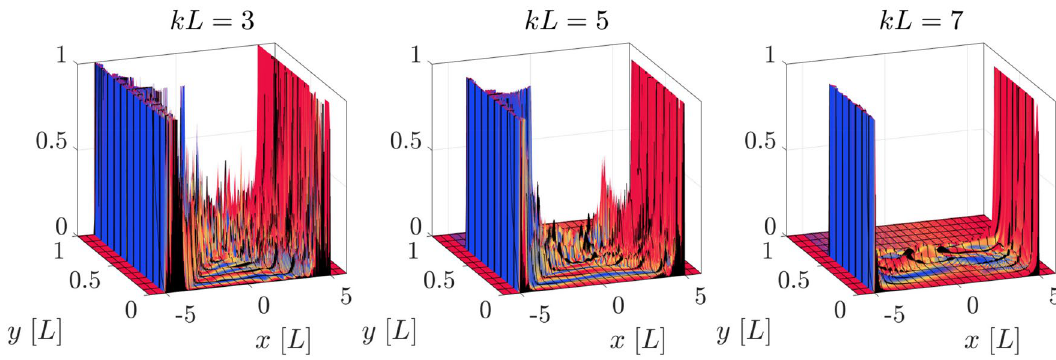
5 L , for an initially localized walker centered at =